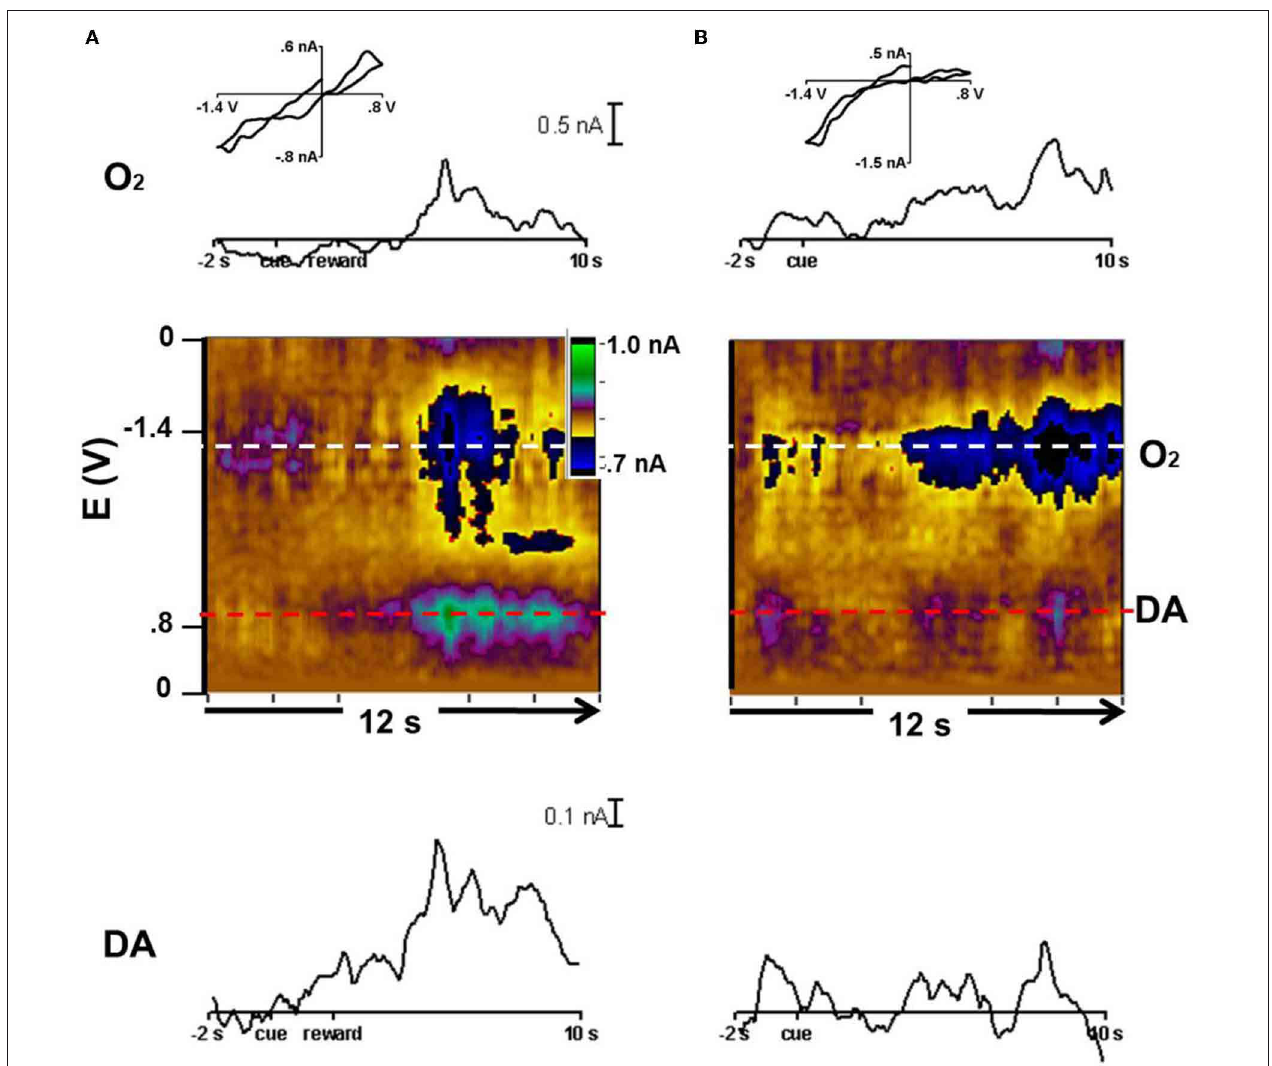
FIGURE 5 | Dopamine-like signal and oxygen increases in p = 0 . 50 trials. Current vs. time trace, color plot, and representative cyclic voltammogram for dopamine and O 2 . (A) Reward trials averaged to the cue at 0s. The current vs time trace for O 2 (horizontal white line in color plot) and dopamine (red in color plot). Below: the average color plot of 22 rewarded trials in which the